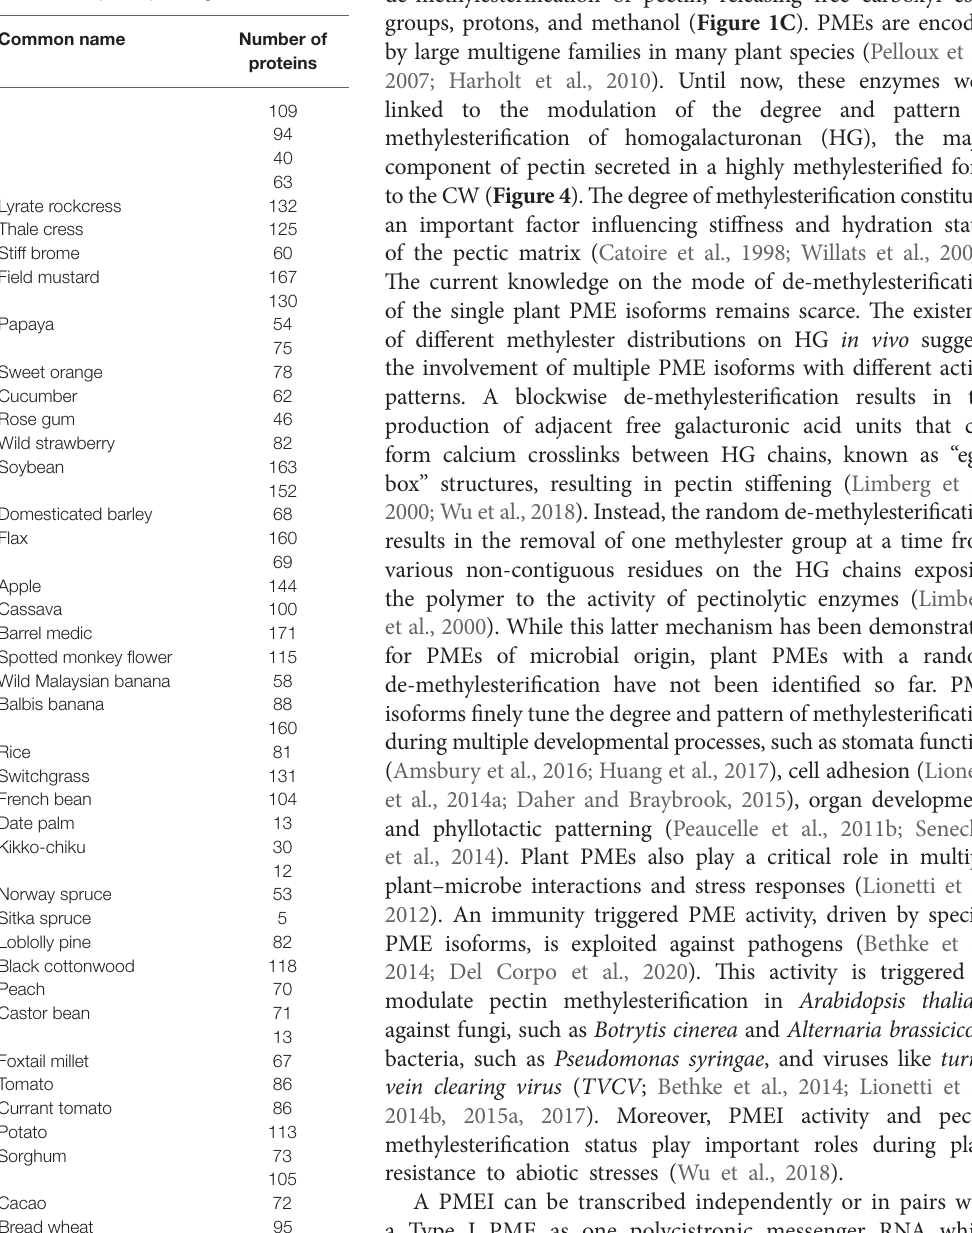
TABLE 1 | INVI/PMEIs assignments in different plant species